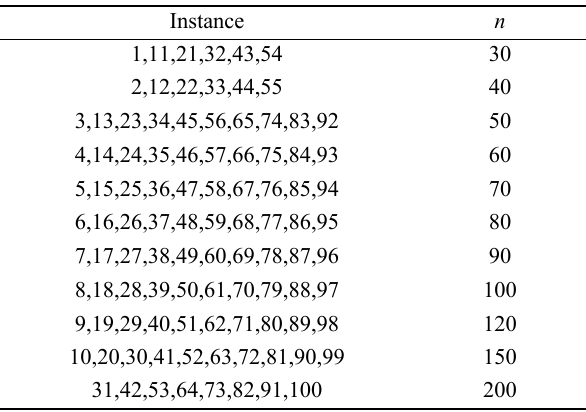
Table 3 Information of number of jobs on 100 instances.